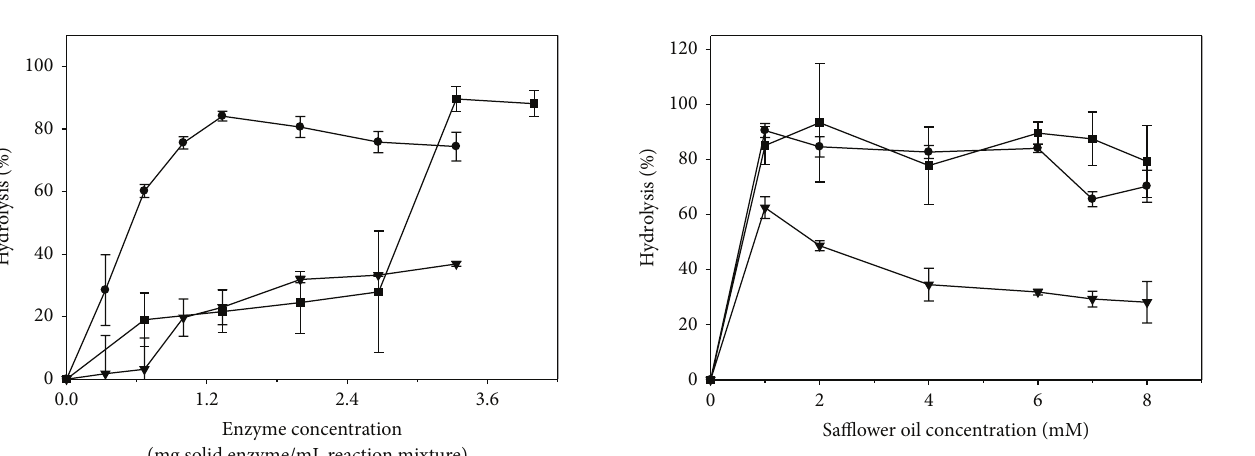
Figure 3: Effect of substrate concentration on the hydrolysis of safflower oil, using lipases from Candida rugosa type VII (CRL) ( e ), porcine pancreas type II (PPL) ( 󳶃 ), and Thermomyces lanuginosus (Lipozyme TL IM) ( ◼ ). The optimal biocatalyst amount was 1.3 and 2.0mg solid enzyme/mL reaction mixture for CRL and PPL, respectively, and 3.3 mg granular enzyme/mL reaction mixture for Lipozyme TL